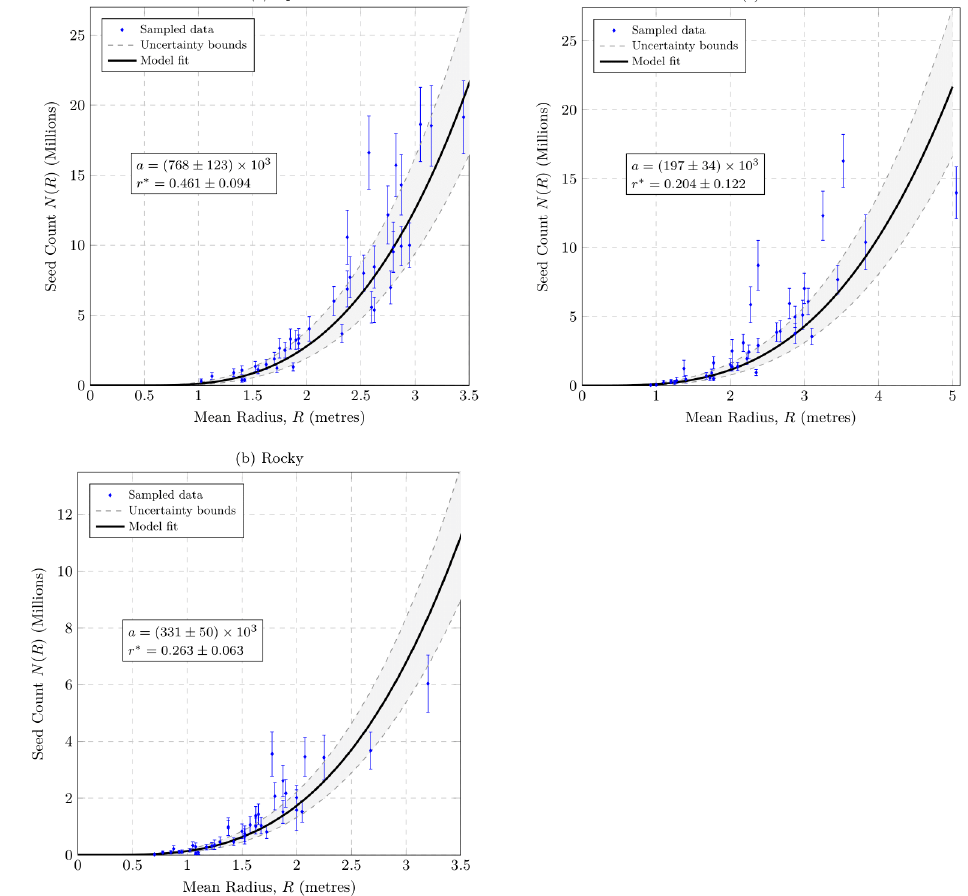
Figure 2. The mean radius of sampled Pyracantha angustifolia shrubs in relation to the mean number of seeds produced in millions for the three sampled field sites in ( a ) grassland, ( b ) rocky outcrops, and ( c ) riverine habitats. Dots on each graph show mean number of seeds and error bars indicate minimum and maximum seed counts.